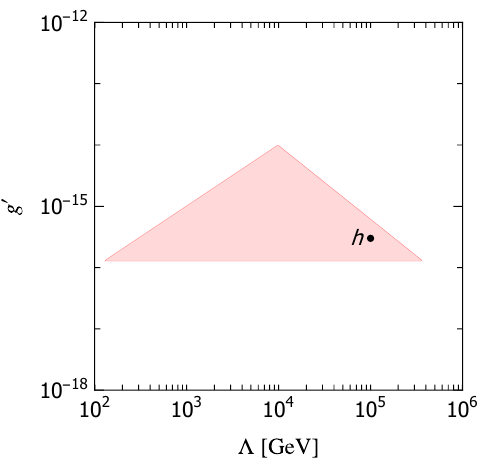
Figure 6 . Allowed parameter space for self-stopping relaxion in the case where the relaxion dom- inates the energy density of the universe and slow-rolls during